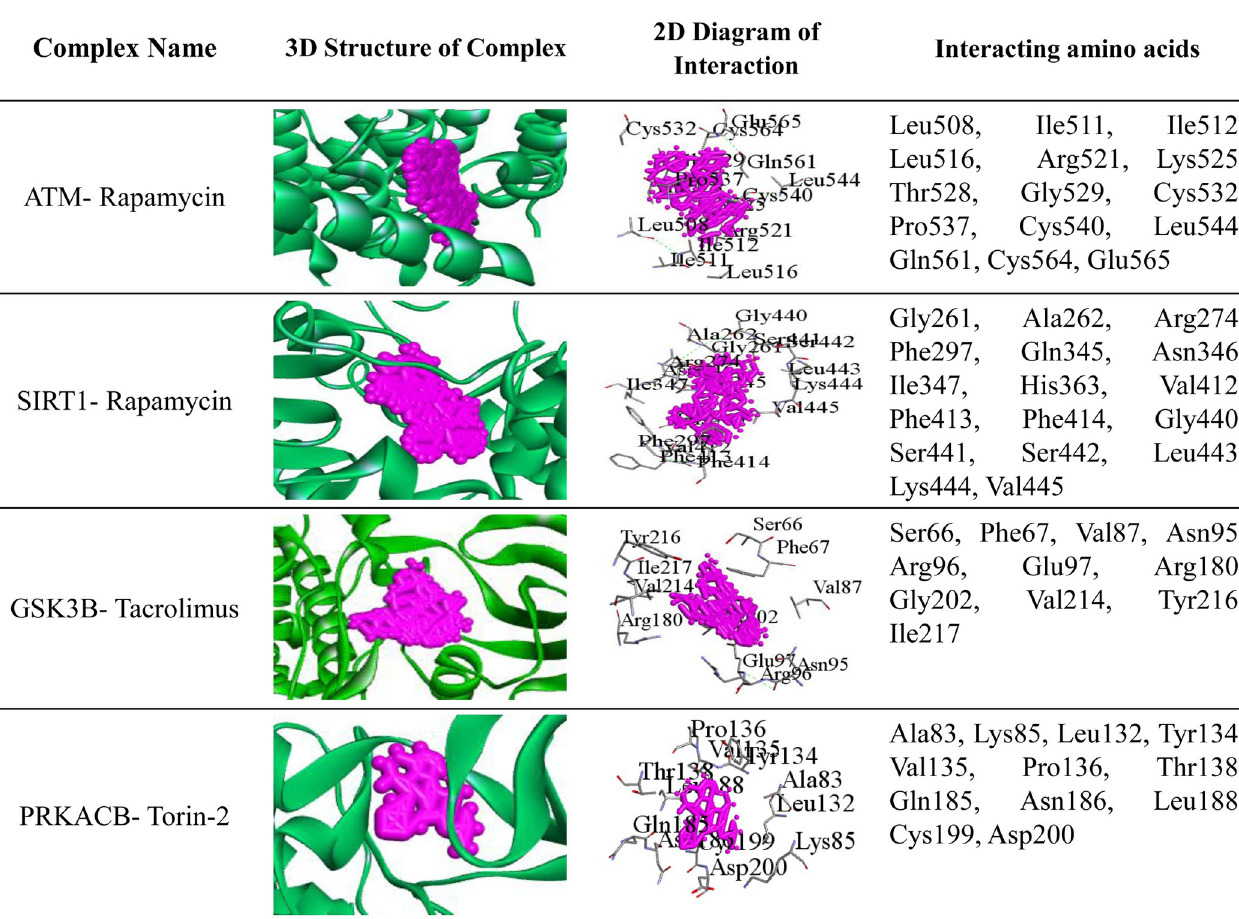
Fig 10. Top 4 potential targets and top 3 lead compounds (drugs) based on PatchDock docking results. The 3D structures of complexes are shown in 2nd column. The 2D Schematic diagrams of complexes are given in 3rd column and neighbor interacting residues (within 4 Å of the drug) are shown in the last column.